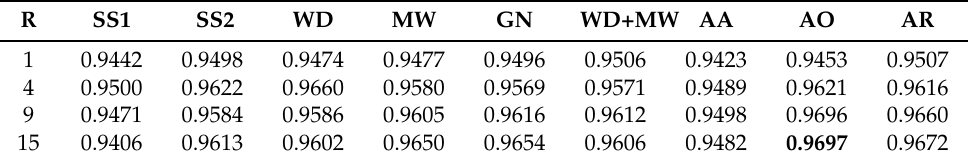
Table A7. Average accuracy of AtzoriNet* for each method at different augmentation ratios, R , for the putEMG dataset. The value in bold corresponds to the method with highest accuracy.